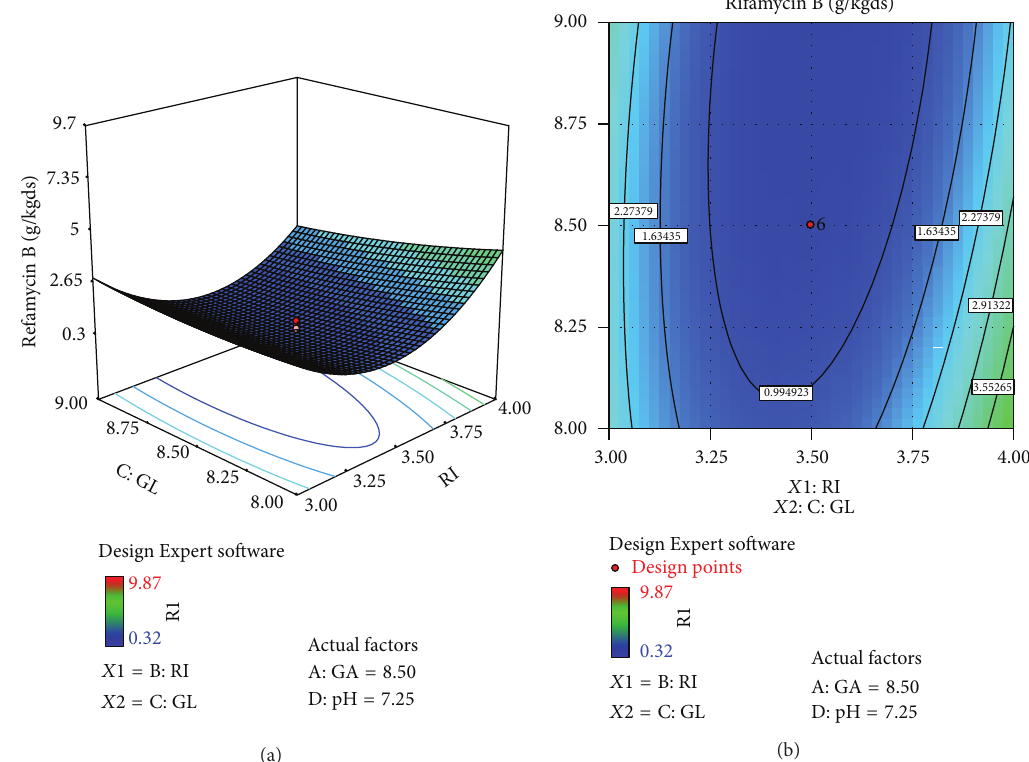
Figure 10: Surface and contour plot for rifamycin B production at varying concentrations of 𝑋3 , ribose (RI), and 𝑋1 , glucose